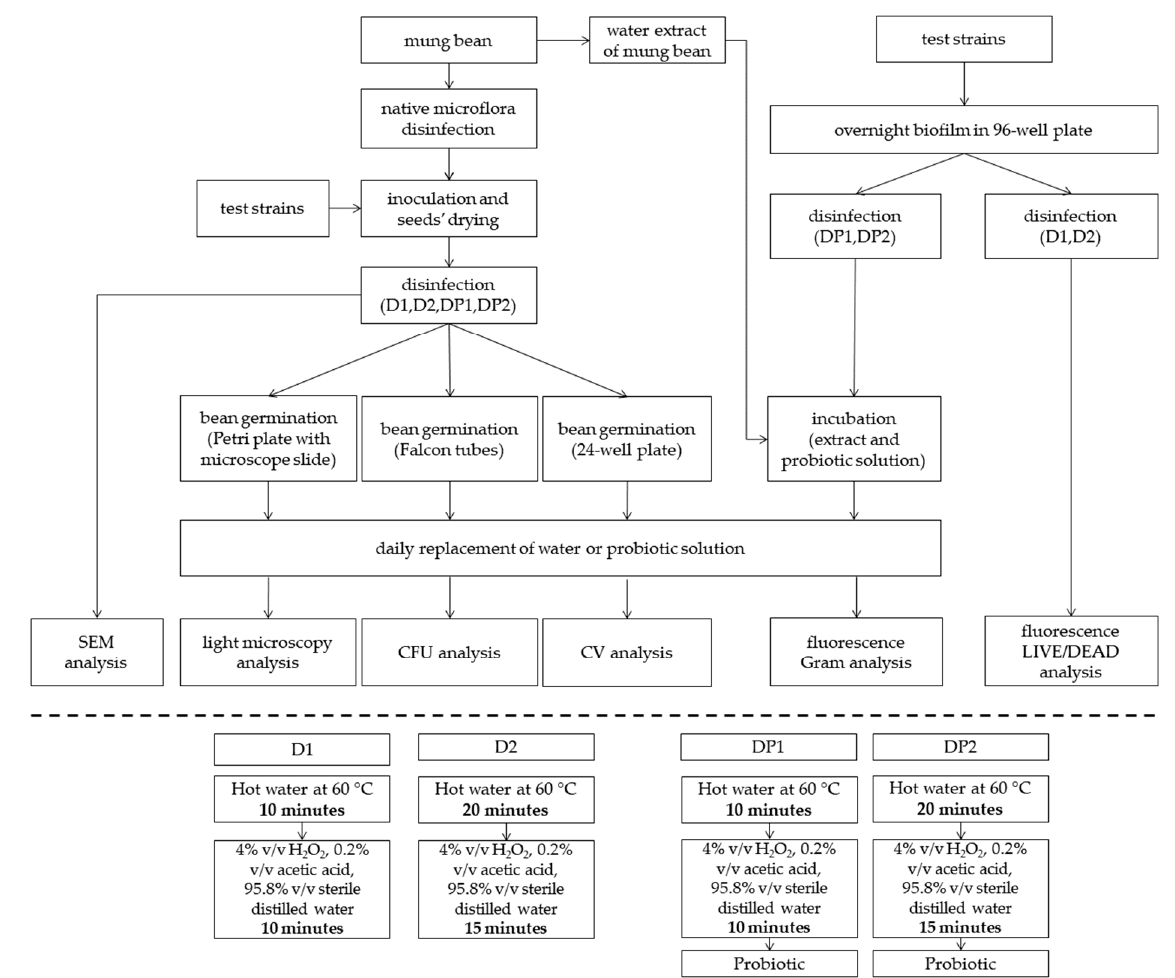
Figure 1. Schematic diagram of the experiment and disinfection methods (D1, D2, DP1, DP2); probiotic— L. plantarum 299v. D1—disinfected with the 1st method; D2—disinfected with the 2nd method; DP1—disinfected with the 1st method + L. plantarum 299v; DP2—disinfected with the 2nd method + L. plantarum 299v; SEM—Scanning Electron Microscopy; CFU—Colony Formation Units; CV—Crystal Violet method.